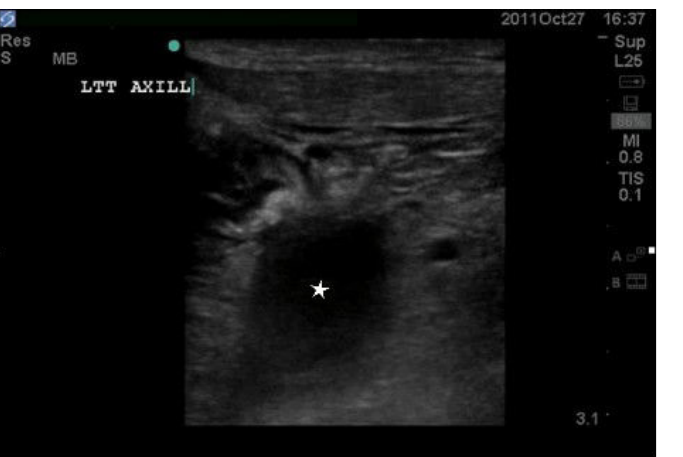
Figure 4. Ultrasound image demonstrating clot in right axillary vein (star).